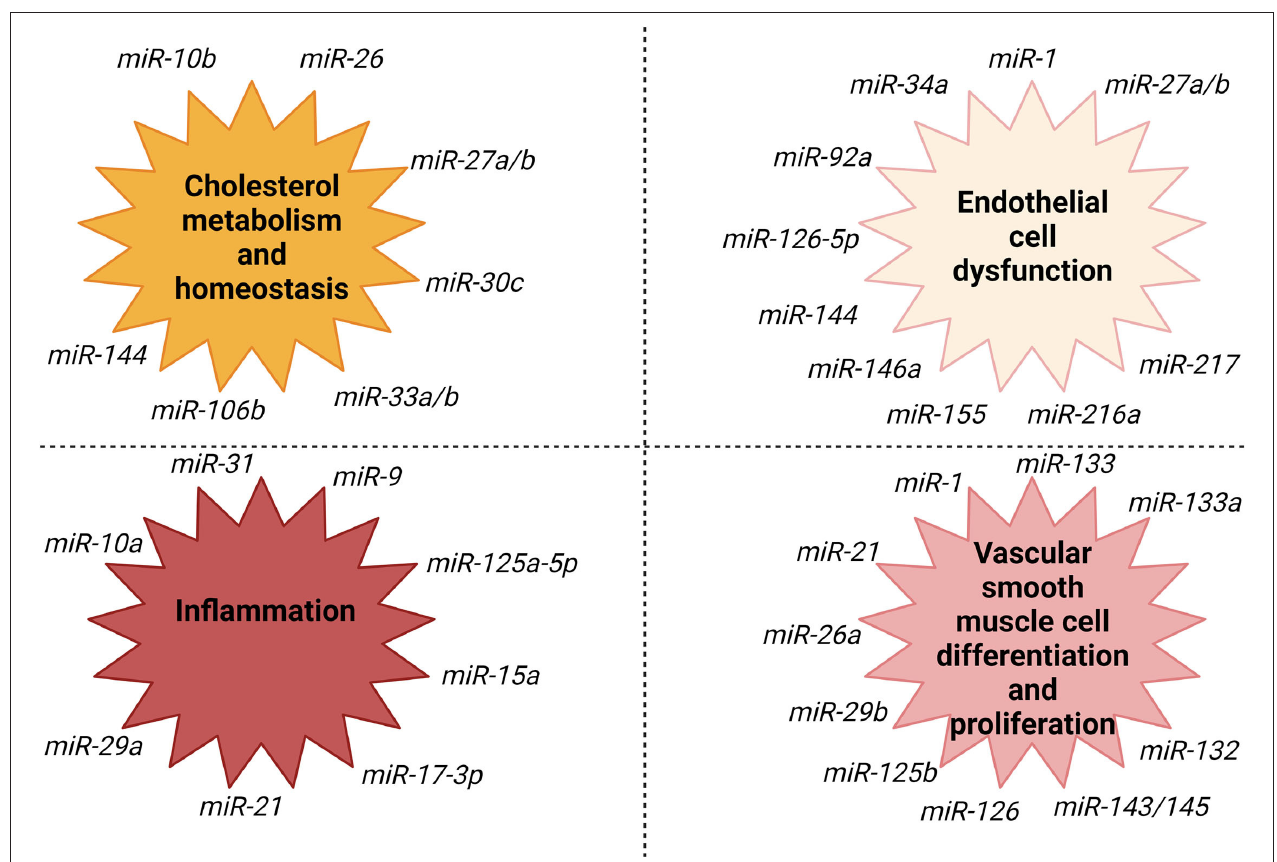
FIGURE 3 | miRNAs association with fundamental processes involved in the evolution of atherosclerosis. Created with BioRender.com (Last accessed on 16 January